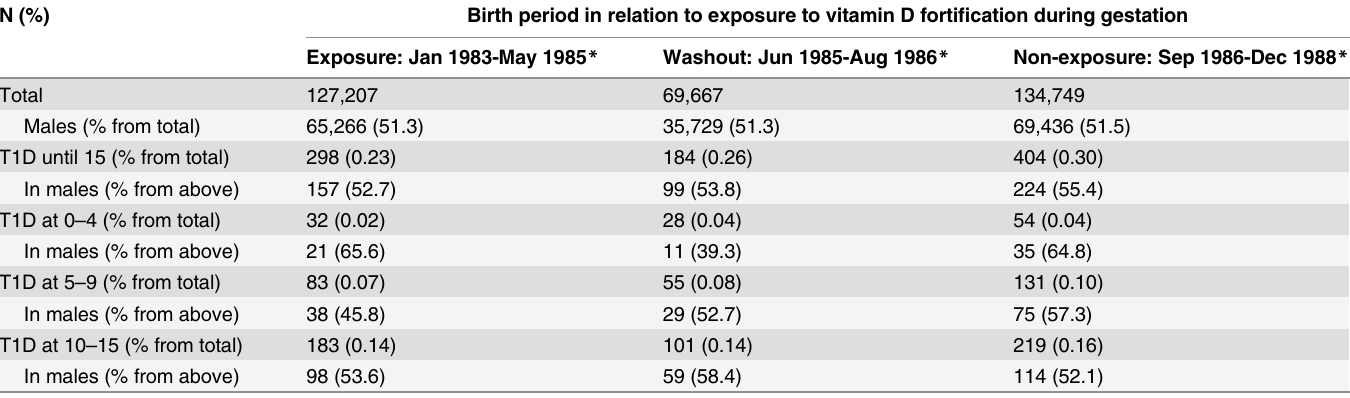
Table 1. Studied population by periods of various gestational exposures to vitamin D fortification, T1D onset age, and sex.